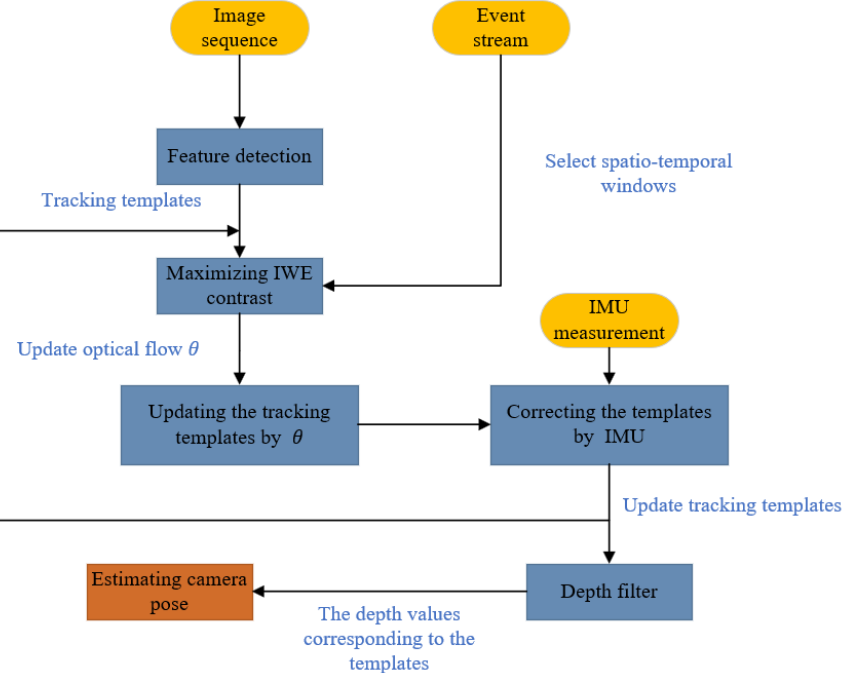
Figure 1. An overview of the visual odometry method. θ is the optical flow of the event in the corresponding spatio-temporal window.